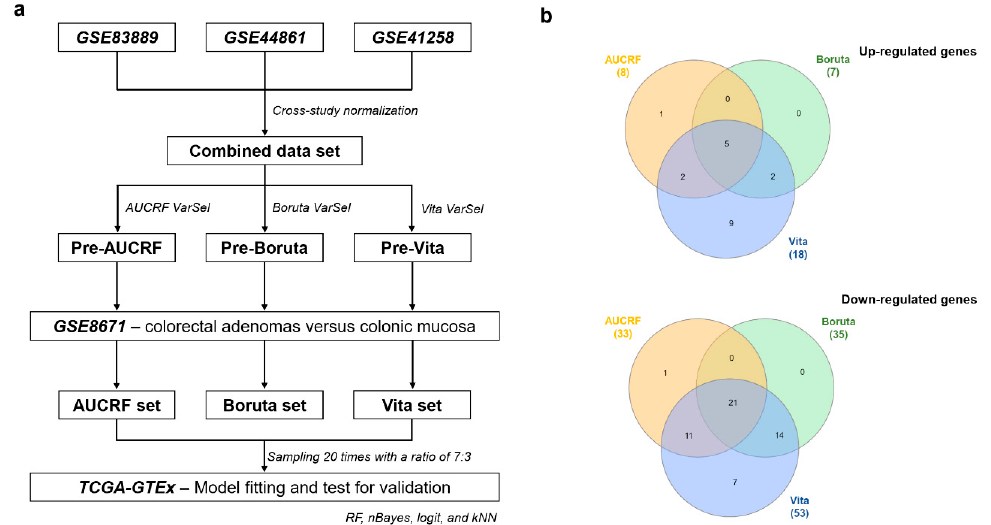
Figure 1. Workflow of the biomarker candidate selection. ( a ) The process of selecting and validating diagnostic candidates with three different variable selection algorithms. ( b ) The Venn diagram demonstrating the relationships of selected biomarker candidates among three methods. VarSel: Variable selection; RF: Random Forest; AUCRF: the area under the curve (AUC)-RF; nBayes: naïve Bayes; logit: logistic regression; kNN: k-nearest neighbors.